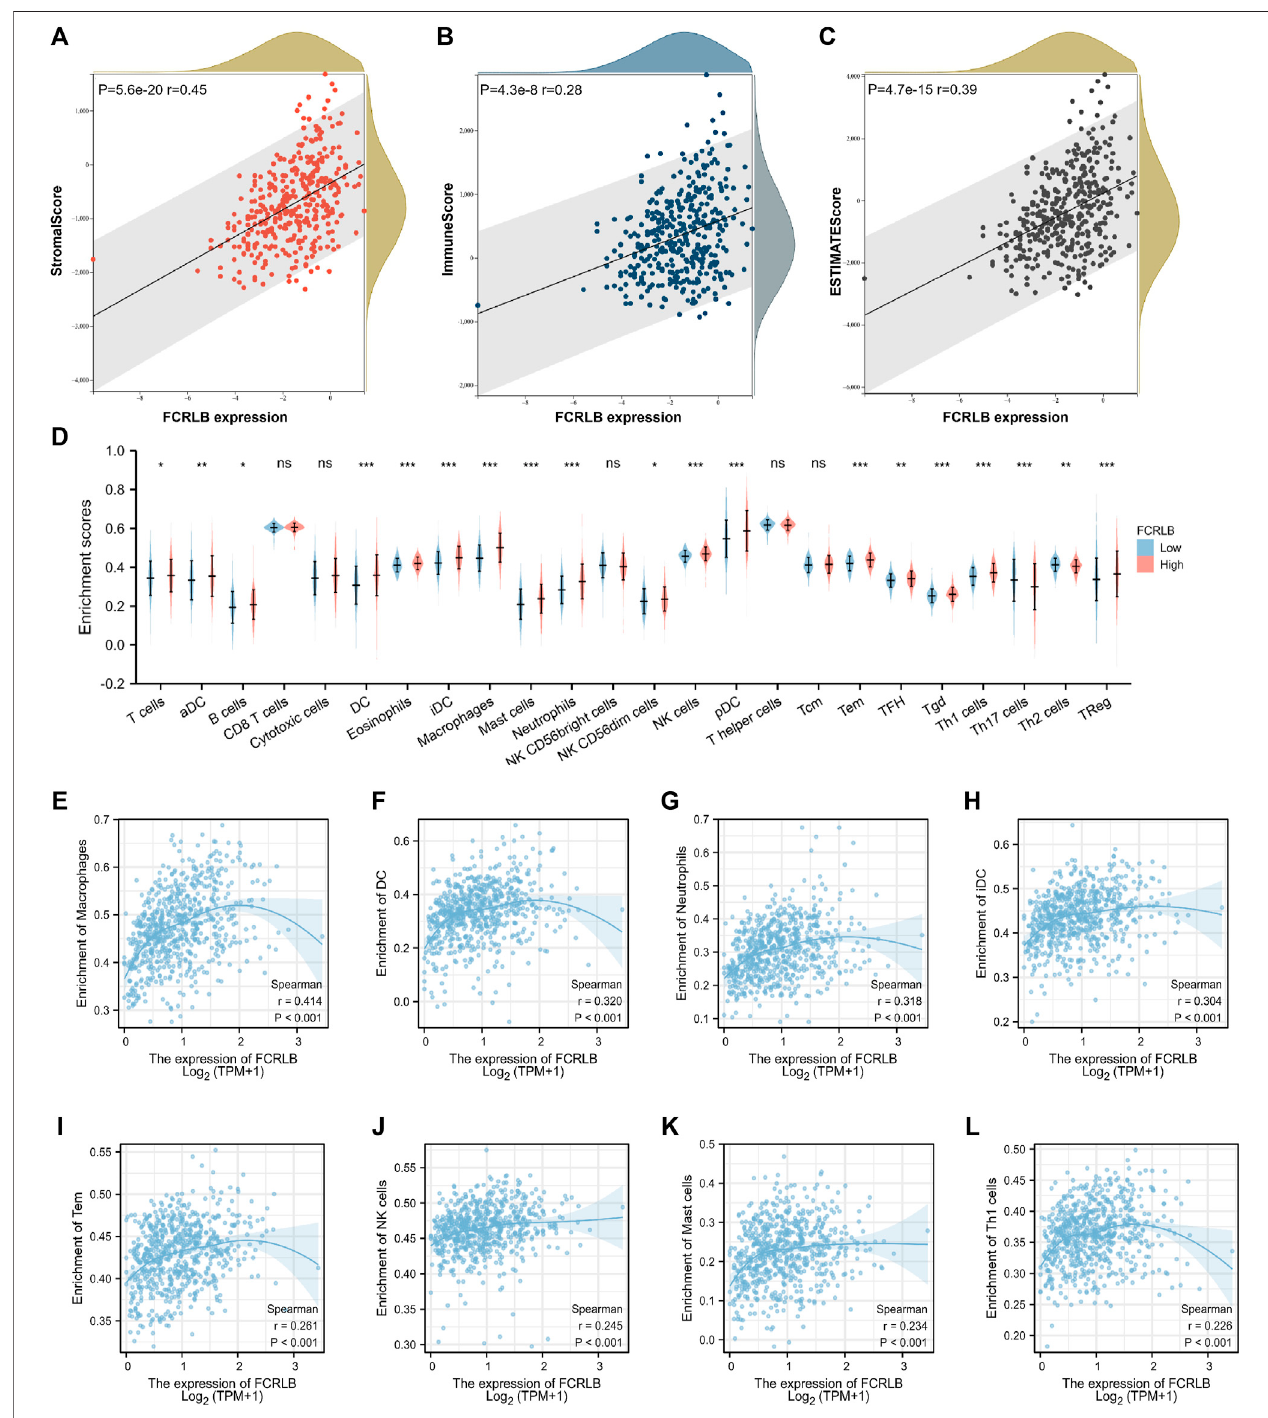
FIGURE 9 | The relationship between FCRLB expression and immune cell in fi ltration in TCGA CRC cohort. (A – C) The relationship between FCRLB expression levels and the StromalScore, ImmuneScore, and ESTIMATEScore. The correlation analysis revealed that FCRLB was positively correlated with the StromalScore (A) , ImmuneScore (B) , and ESTIMATEScore (C) . (D) The relationship betweenFCRLB expression levels and theabundance ofdifferent types ofimmunecells. ns stands for not statistically different. * P < 0.05, ** P < 0.01** and * P < 0.001. (E – L) FCRLB expression was positively correlated with macrophage in fi ltration (E) , DC in fi ltration (F) ,Neutrophilin fi ltration (G) ,iDCin fi ltration (H) ,Temin fi ltration (I) ,NKcellin fi ltration (J) ,Mastcellin fi ltration (K) ,Th1cellin fi ltration (L) ,etc.Sperman ’ scoef fi cient (R) and p-value were noted in each fi gure.